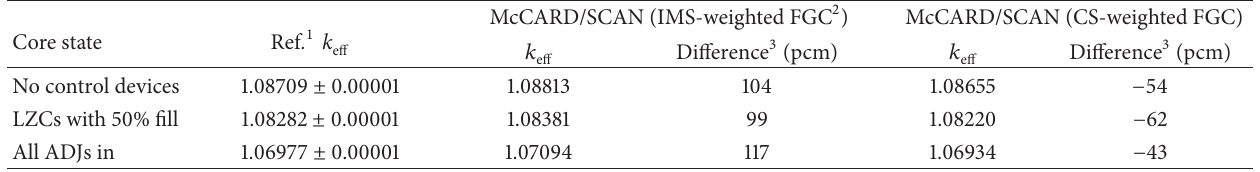
’s for the three core eff